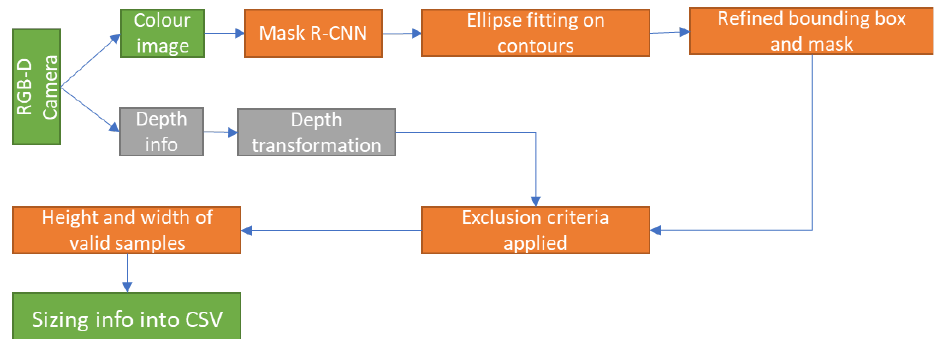
Figure 6. Method 2 – Fruit sizing using Mask R-CNN instance segmentation on the entire image.